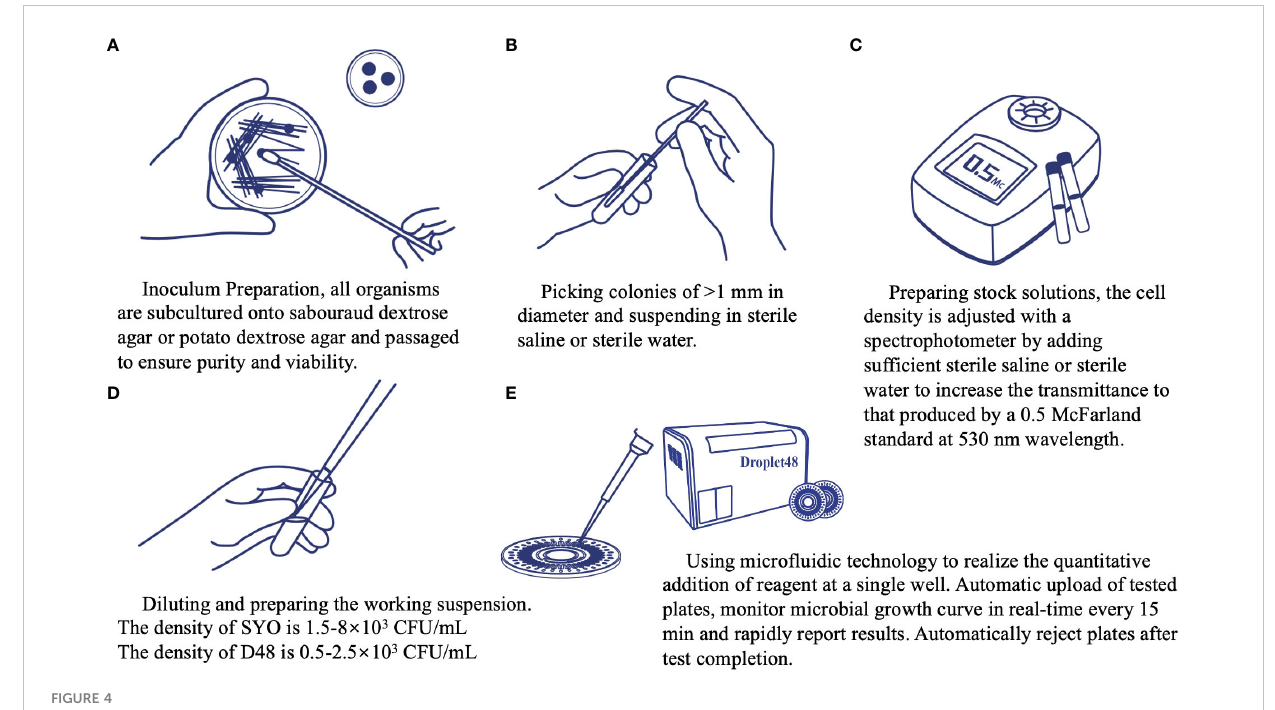
FIGURE 4 Operation procedure of the automated antimicrobial susceptibility testing system, Droplet